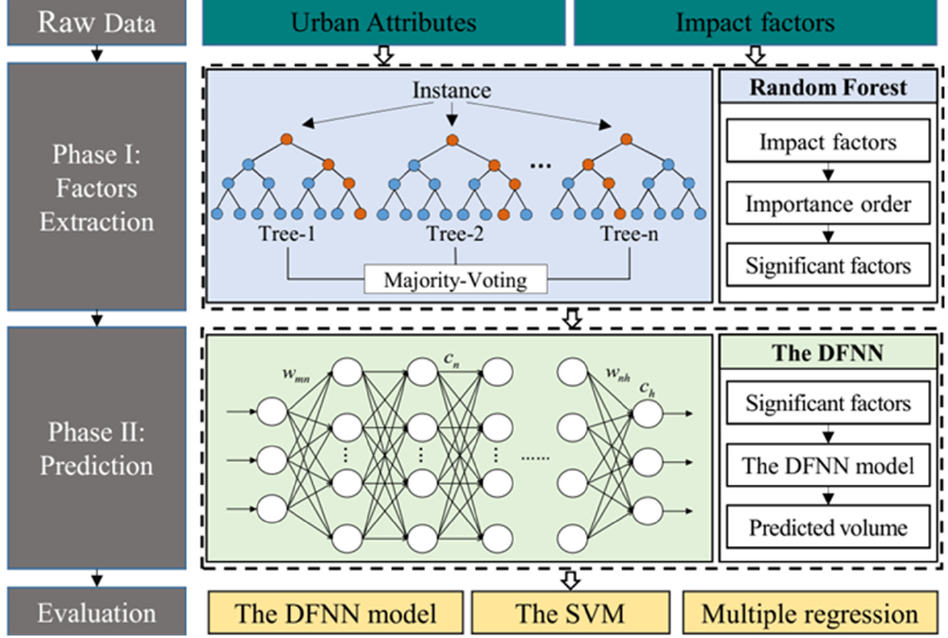
Figure 1. The flow diagram of the designed framework.